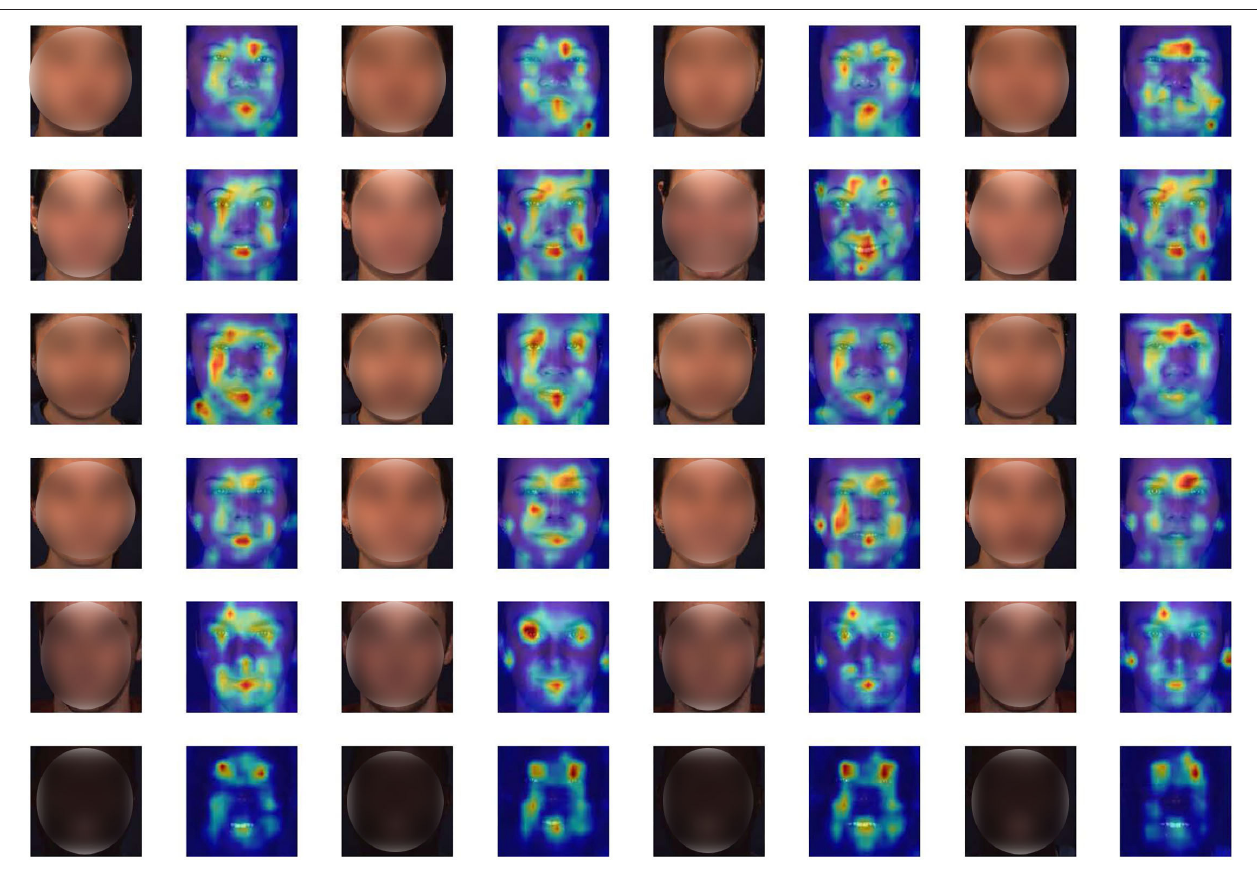
FIGURE 4 | Attention maps of some representative faces. We illustrate a subject with different facial expressions in each row. It is obvious that the proposed PMVT is capable of focusing on the most silent parts for facial AU detection. Deep red denotes high activation, better viewed in color and zoom in.